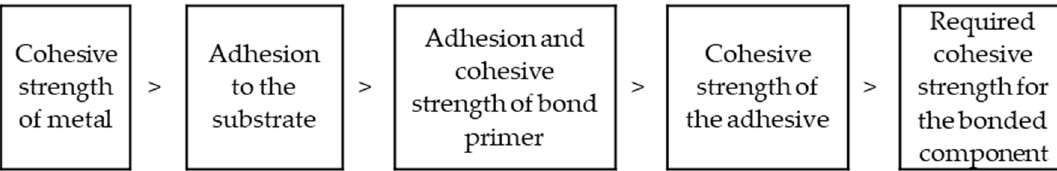
Figure 16. Required strength of the various elements of the adhesive bond system with structural adhesive bonding on aluminum (“>” means larger than, with the highest required strength on the left side, and the lowest required strength on the right side).